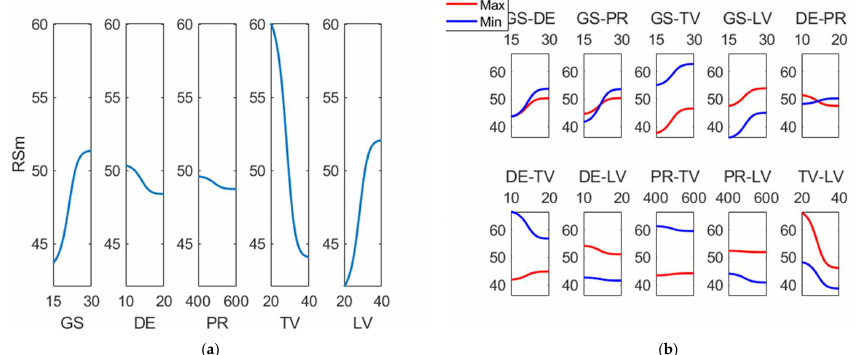
Figure 17. ( a ) Main effects plot and ( b ) interaction effects plot for RSm (µm).